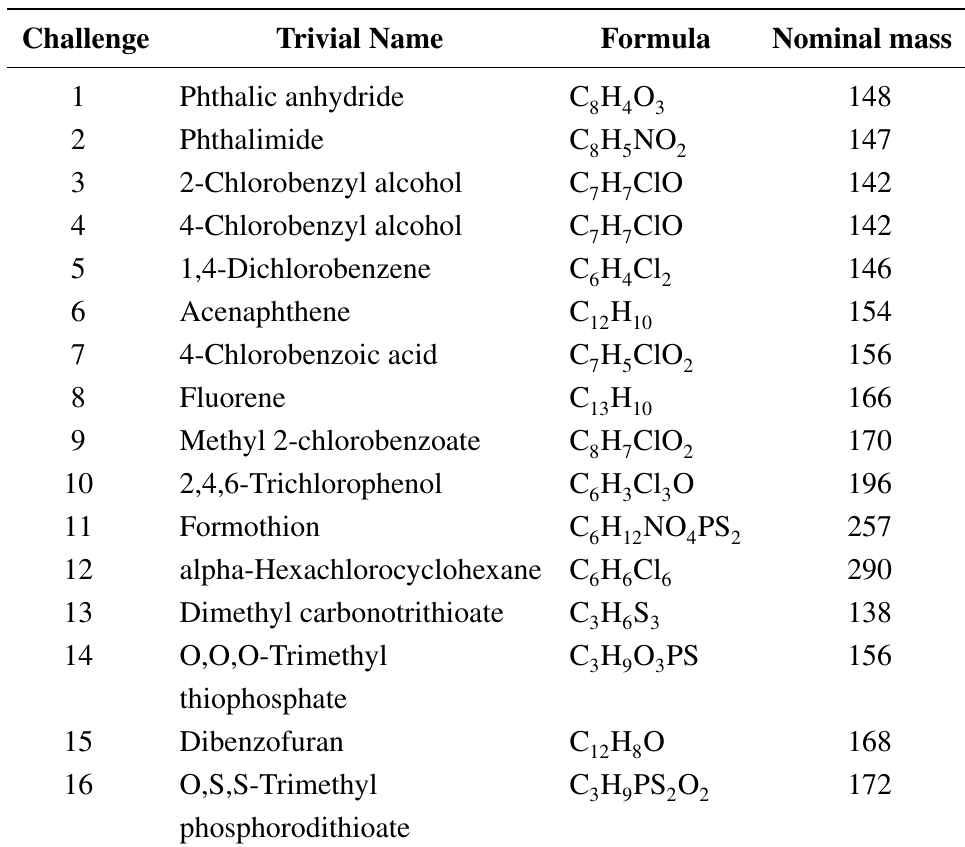
Table 2. Gas chromatography (GC) Challenges for CASMI